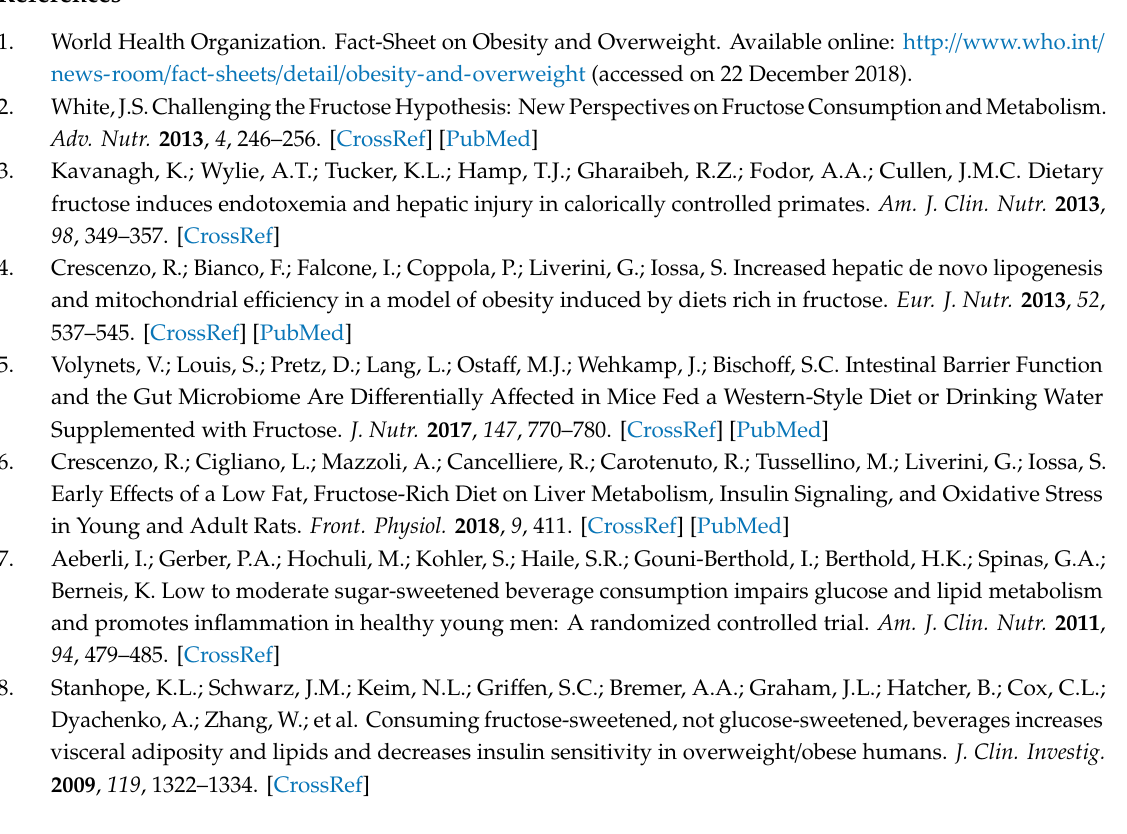
Figure S1: Correlation heatmap (Pearson’s correlation) of gut microbiota within 6 taxon levels and clinical parameters. Table S1: KEGG modules significantly associated with